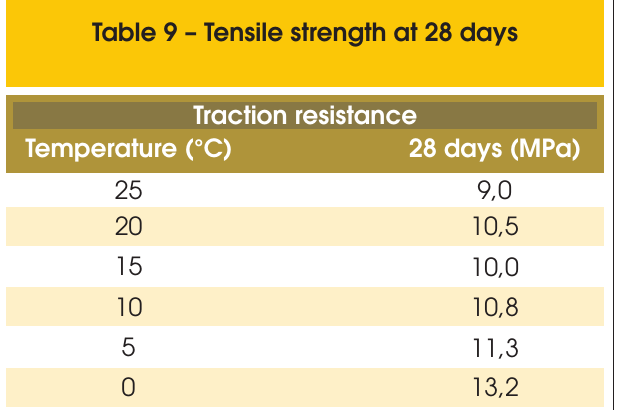
Table 9 – Tensile strength at 28 days Traction resistance